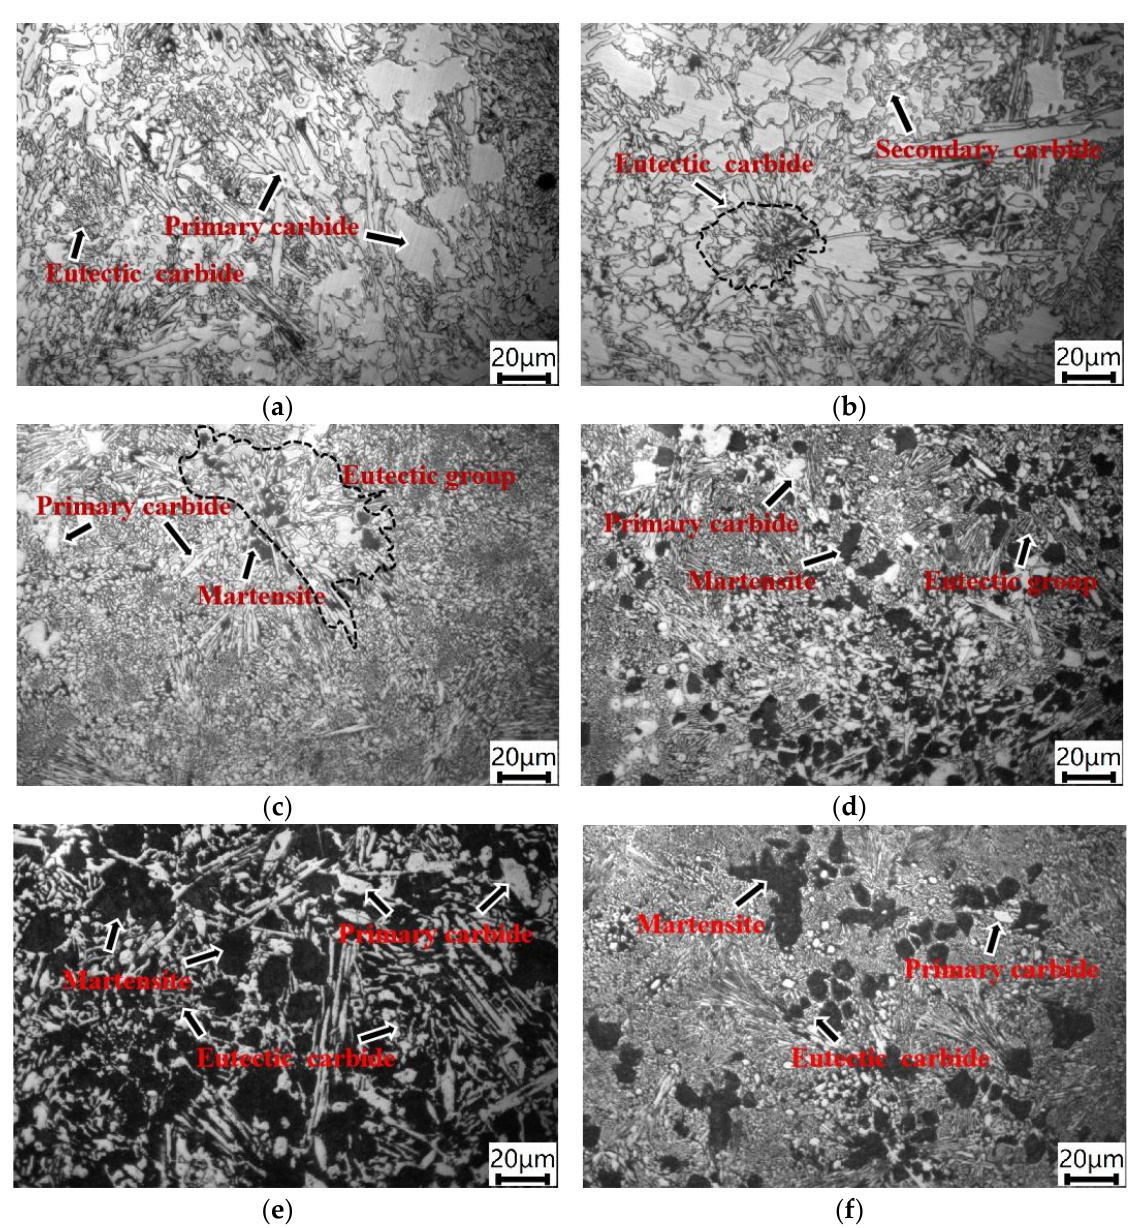
Figure 3. Optical microstructures of the control group and the five groups after subcritical quenching at different temperatures: ( a ) without heat treatment; ( b ) 500 ◦ C-quenching; ( c ) 530 ◦ C-quenching; ( d ) 550 ◦ C-quenching; ( e ) 580 ◦ C-quenching; ( f ) 630 ◦